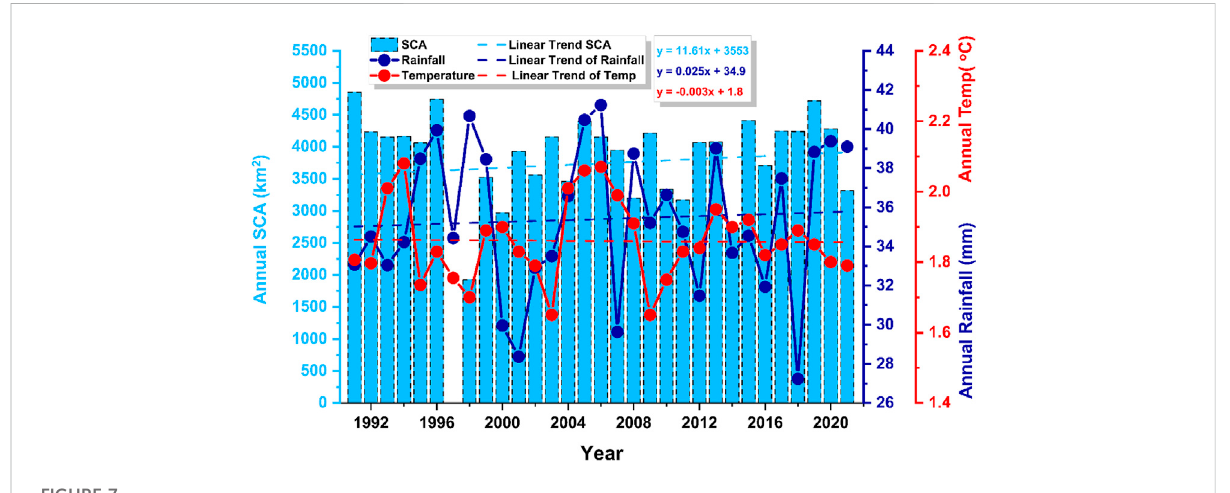
FIGURE 7 Annual SCA, rainfall, and temperature of